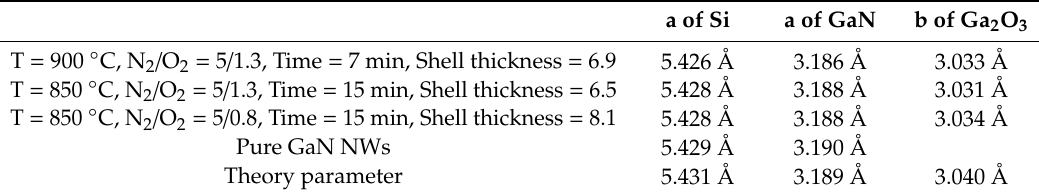
Table 3. Parameters of crystals extracted from XRD